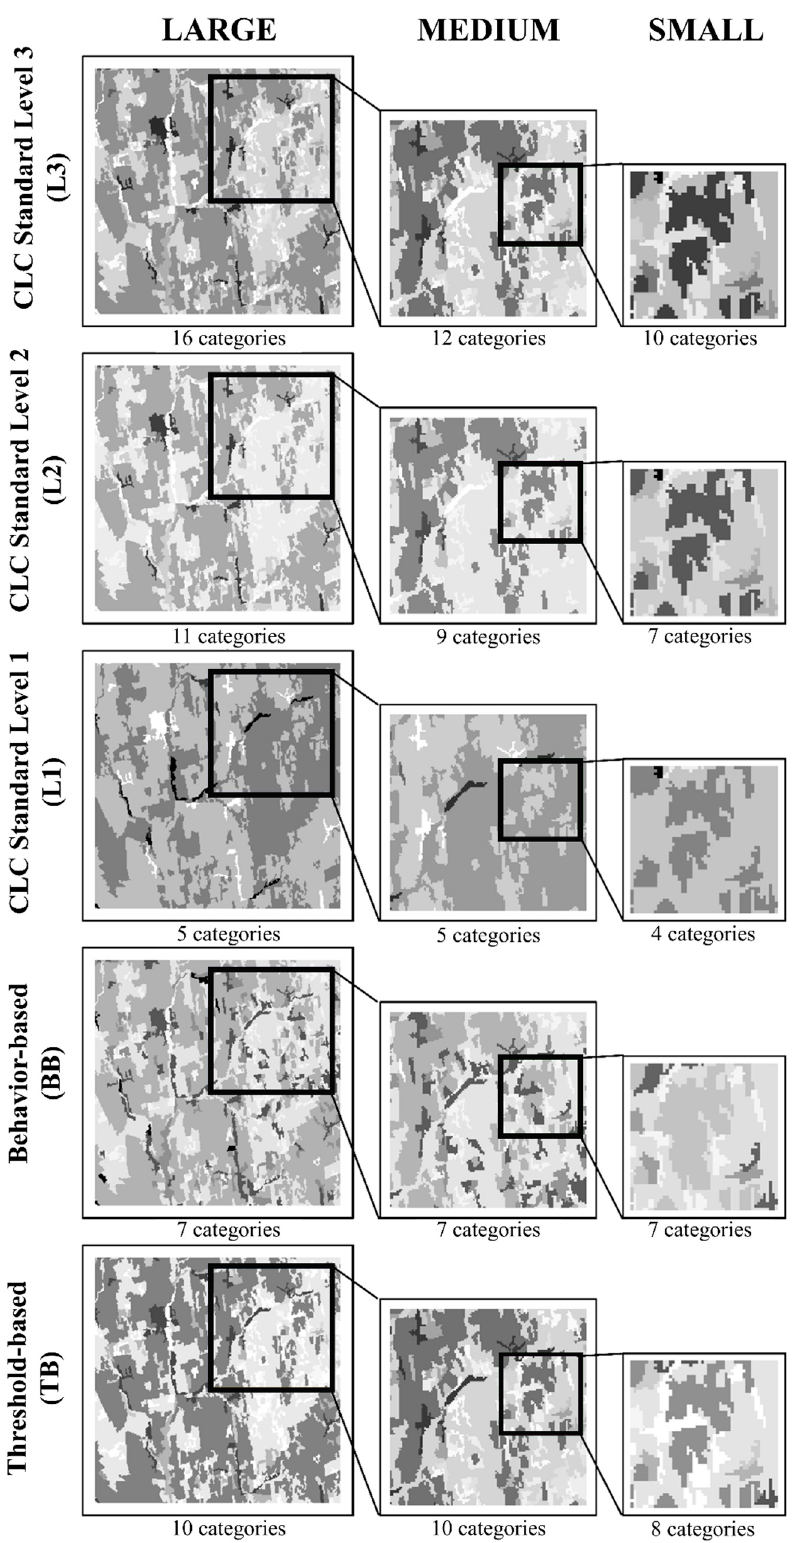
Figure 3. Categories of a study area shown by zoom level in columns and aggregation methods in rows, assigned with the actual category numbers evolved as the result of aggregation. Shades of grey are not assigned to actual categories, but help to distinguish patches.